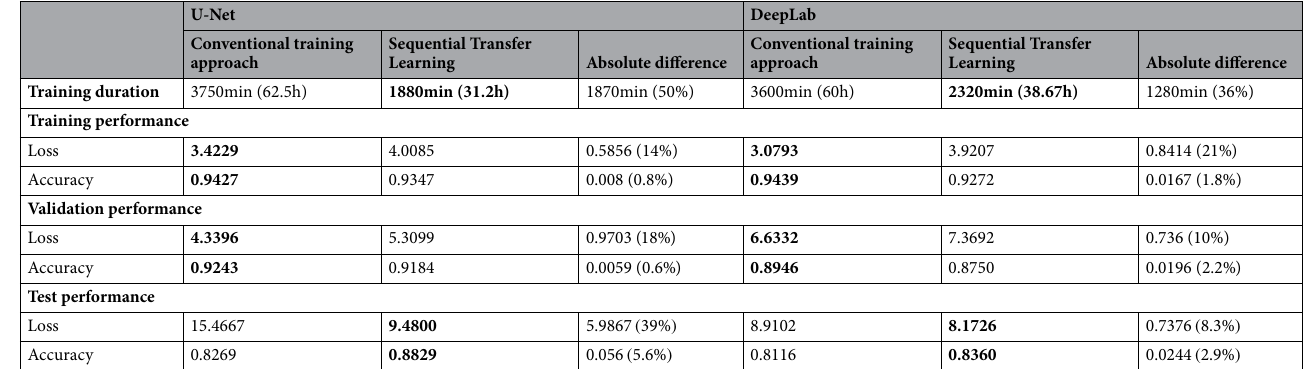
Table 1. Training and test set performances. Network performance comparison table, holding training, validation and test set performance information evaluated for both network architectures, U-Net and DeepLab. The table depicts values of the overall training duration, loss and accuracy levels. Leading results are given in bold.